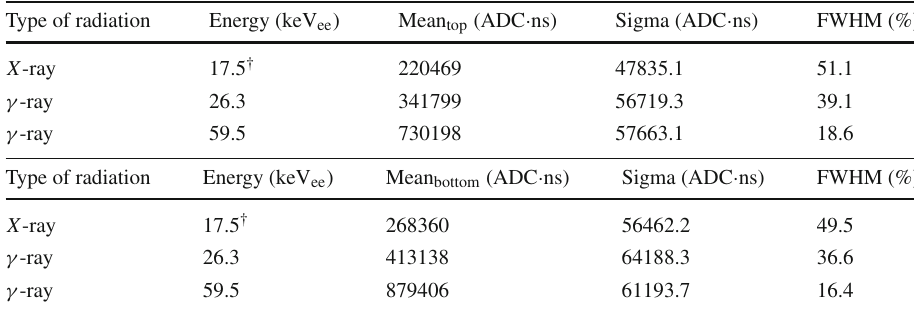
Table 1 Fitting results of 241 Am peaks in energy spectra for the top (top table) and the bottom (bottom table) SiPMs